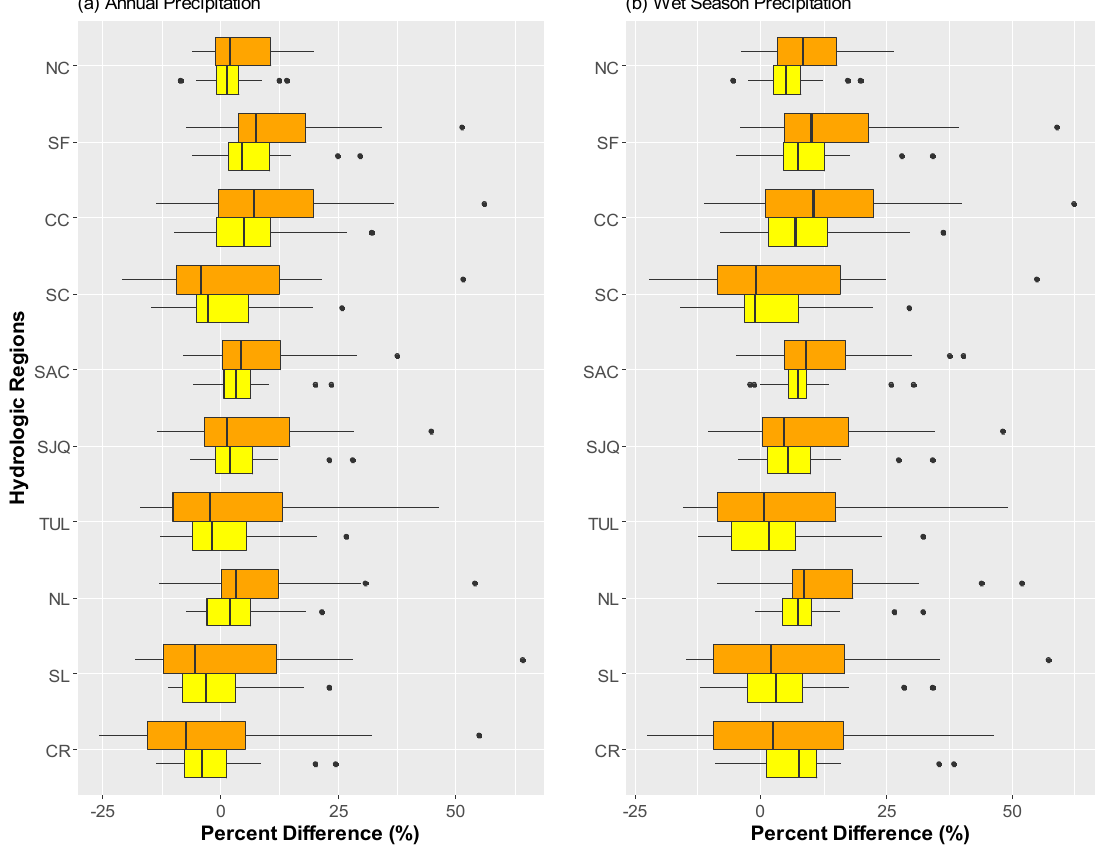
Figure 5. Box-and-whisker plots of percent differences (%) between historical and individual projections on: ( a ) annual precipitation; and ( b ) wet season precipitation. Yellow boxes represent mid-century results and orange boxes show late-century results.